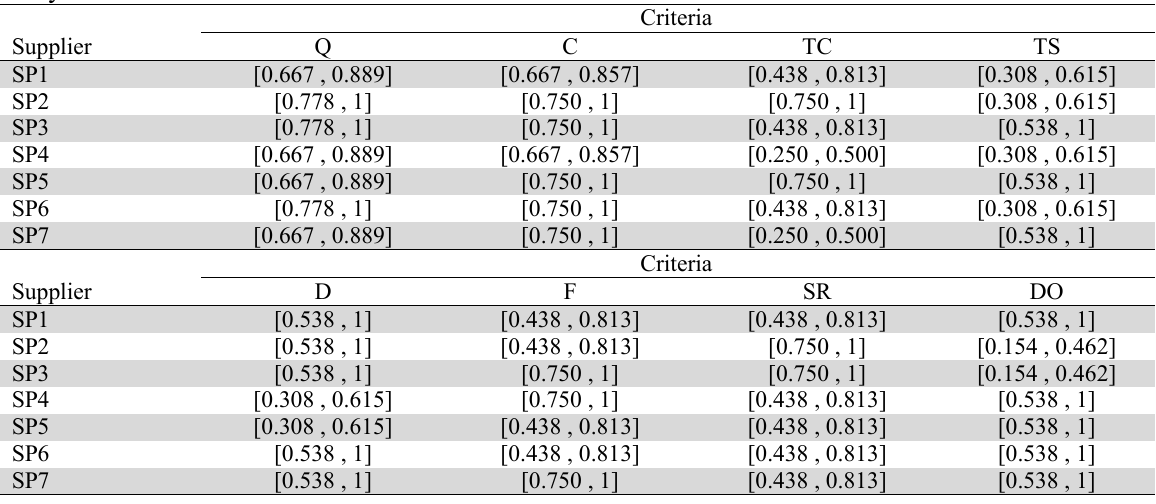
Grey Normalized Values